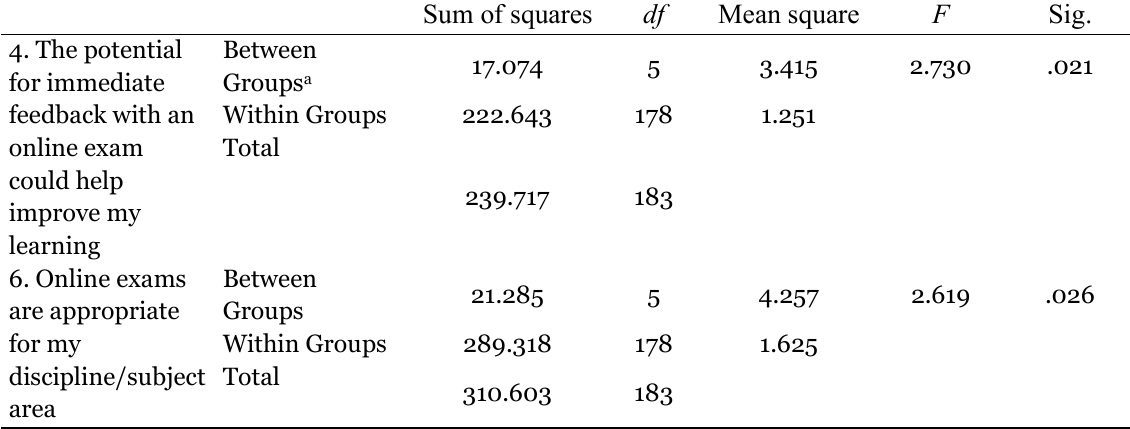
Relationship between the Number of Online Course Taken and Perceptions of Online